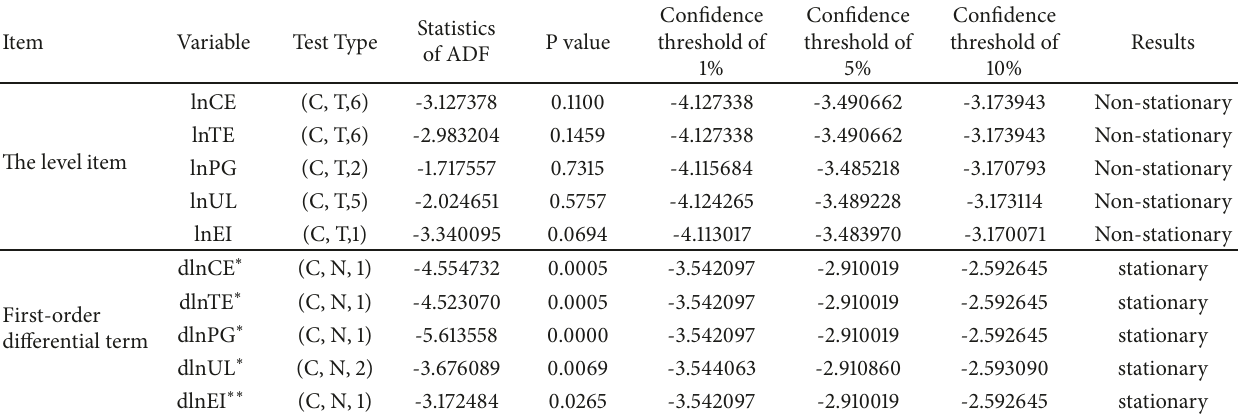
Table 2: The ADF test result for the series.